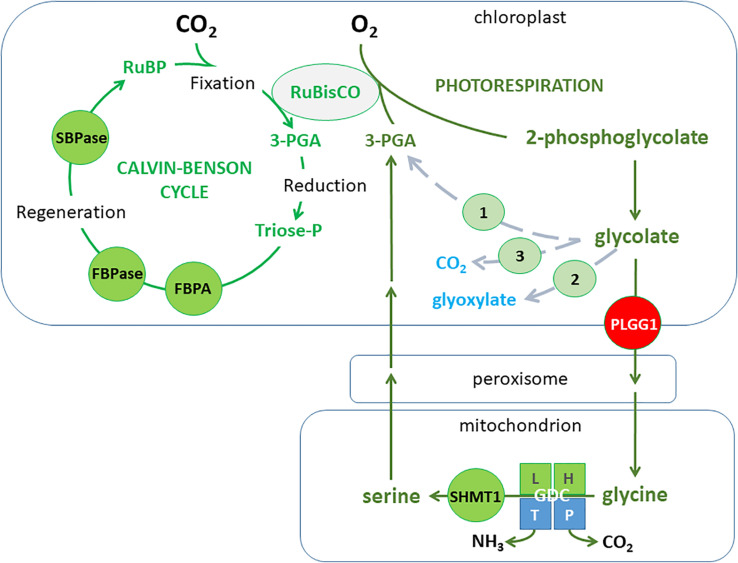
A simplified scheme highlighting tested ways to increase photosynthesis and crop yield by overexpressing selected Calvin cycle enzymes and by creating synthetic chloroplastic photorespiratory bypasses. The enzymes in green circles/squares have been overexpressing either individually or together. Details of the different photorespiratory pathways can be found in the main text: 1 is based on the bacterial glycerate pathway leading to 3-PGA from glycolate (Kebeish et al., 2007; Dalal et al., 2015), 2 is an incomplete glycerate pathway leading to glyoxylate from glycolate (Nölke et al., 2014), 3 are pathways leading to the production of CO2 from glycolate (Maier et al., 2012; Shen et al., 2019; South et al., 2019). The transporter in the red circle was repressed to improve photorespiratory bypasses (see South et al., 2019). Abbreviations can be found in the main text.